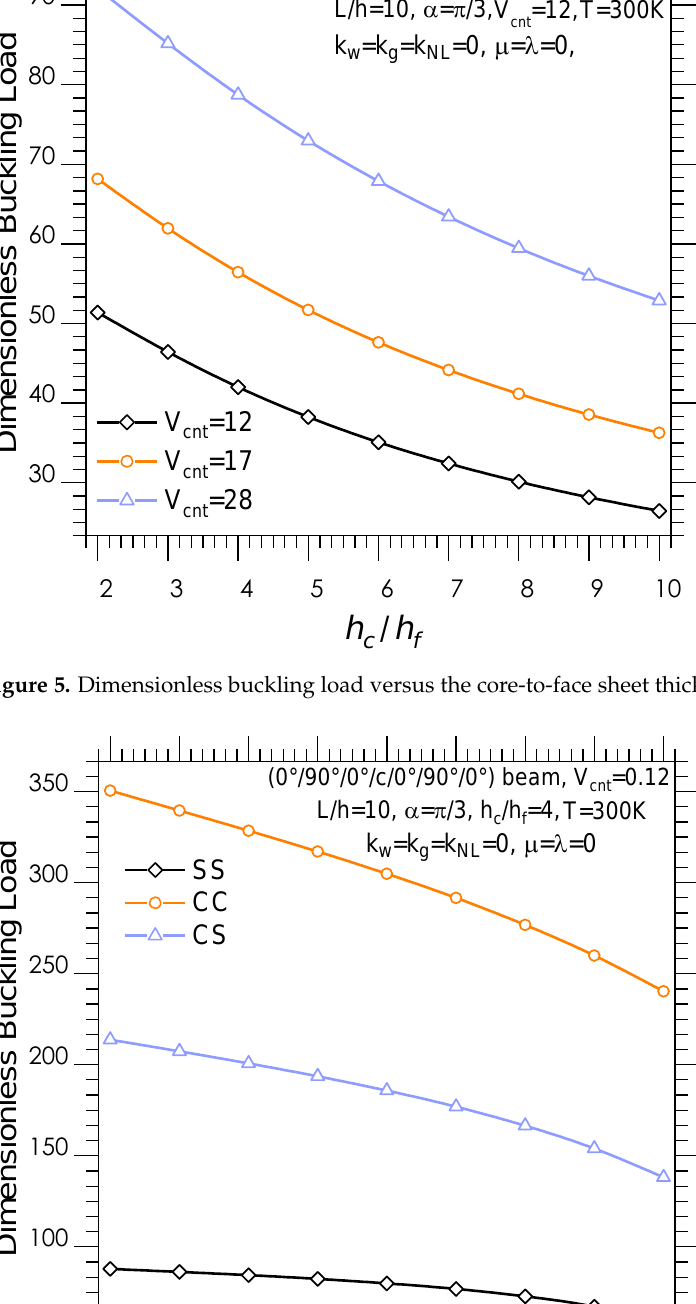
Figure 4. Dimensionless buckling load versus opening angle.